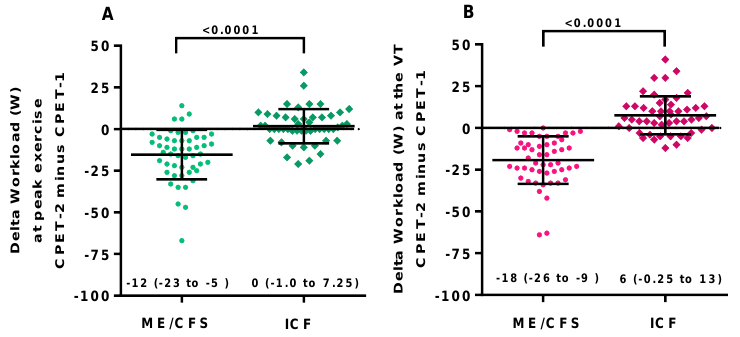
Figure 4. The range of absolute differences for peak workload ( A ) and workload at the ventilatory threshold ( B ) for female ME/CFS and female ICF patients. Legend Figure 4: CPET: cardiopulmonary exercise test; ME/CFS: myalgic encephalomyelitis/chronic fatigue syndrome; ICF: idiopathic chronic fatigue; VT: ventilatory threshold.